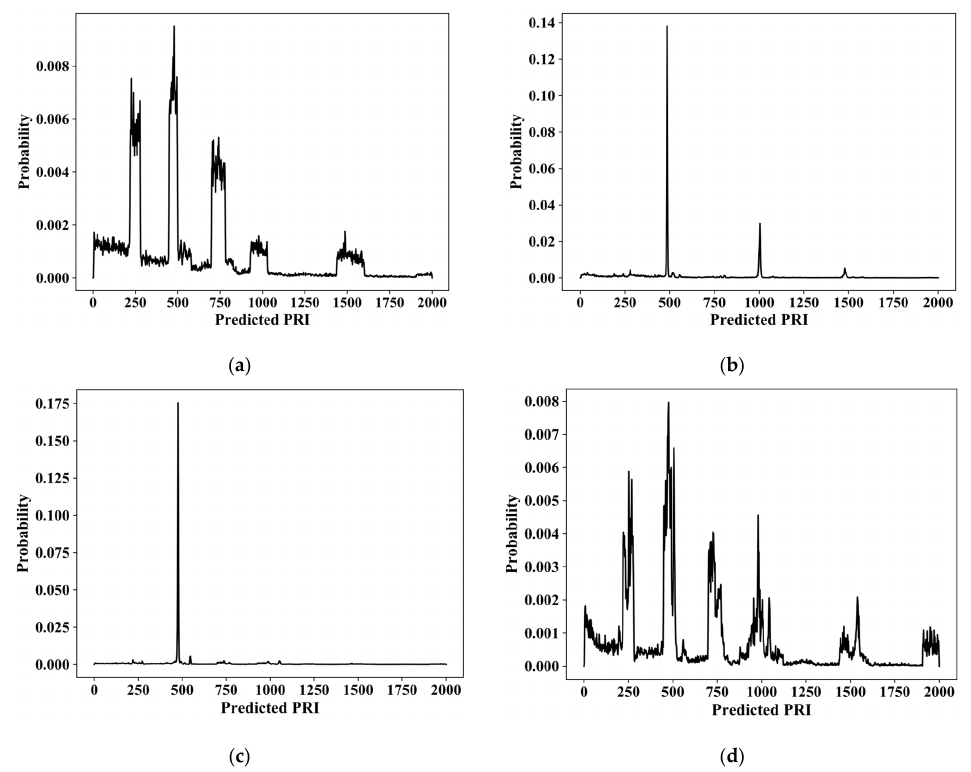
Figure 5. Prediction loss under different data noises. ( a ) MPR = 0.4, IPR = 0.2; ( b ) MPR = 0.4, IPR = 0.6; ( c ) MPR = 0.2, IPR = 0.4; ( d ) MPR = 0.6, IPR = 0.4.